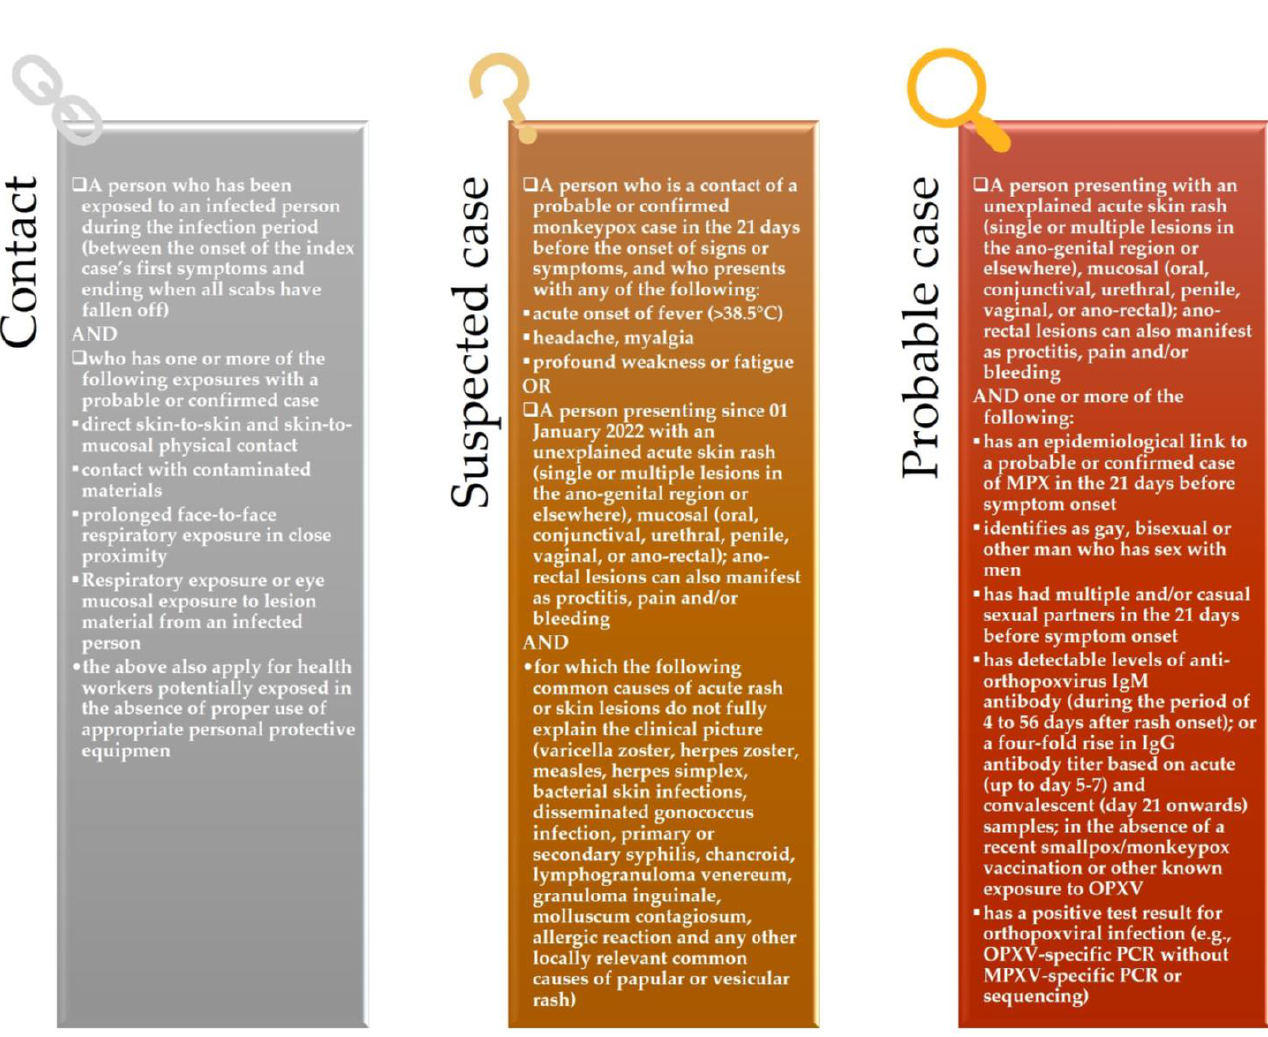
Figure 1. WHO definitions of MPX contact, suspected case, and probable case. As per currently accepted UK Health Security Agency guidelines [48,49], MPX diag-